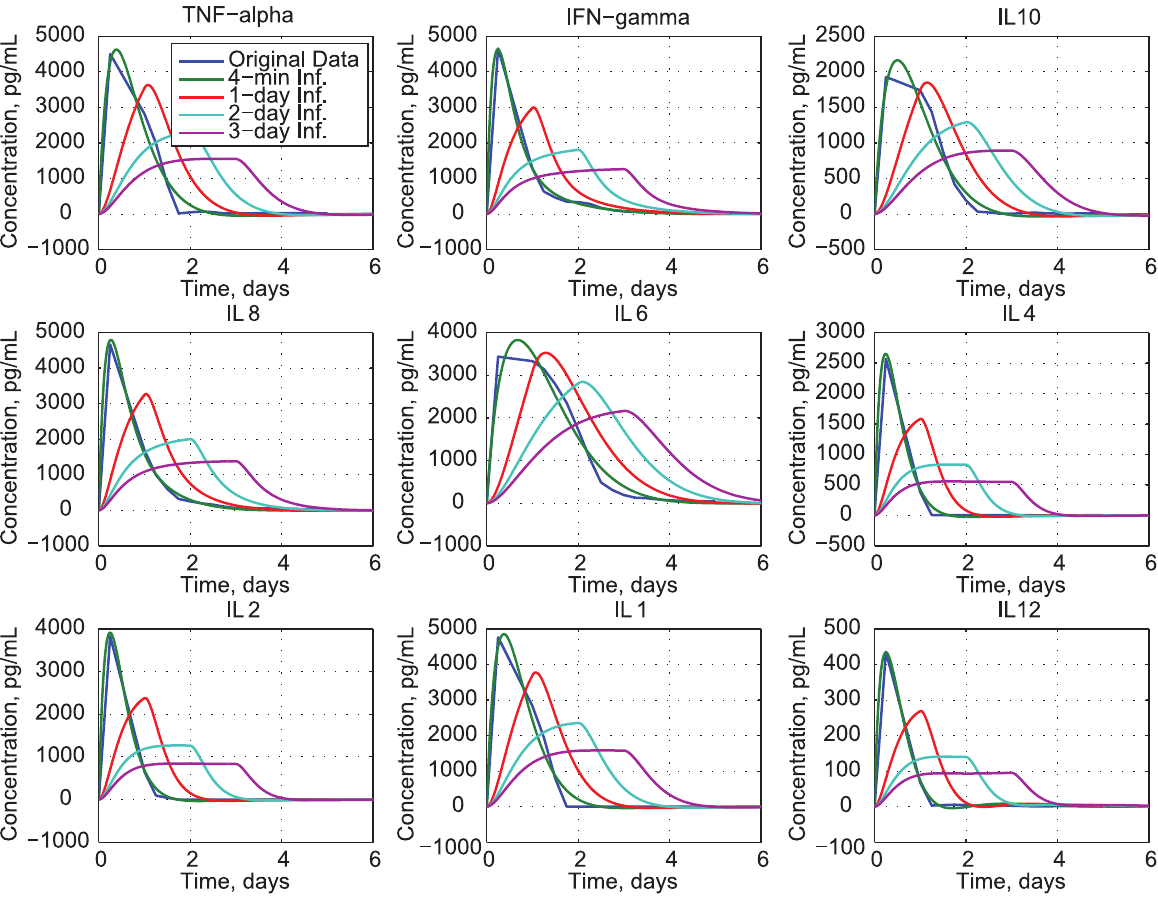
Figure 12. Effects of TGN1412 infusion duration of four minutes to three days on cytokine response. Dosage =8 mg.